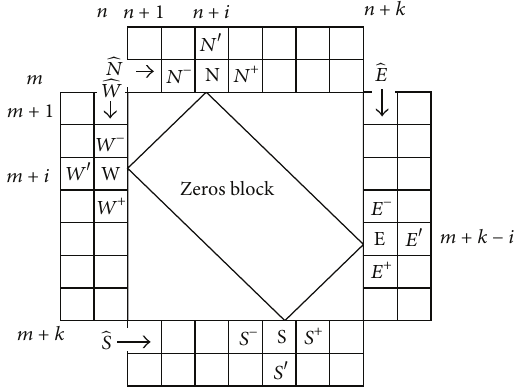
Figure 2: Location of elements in (𝑚, 𝑛;8) block for Gilewicz- Froissart and Paszkowski identities.